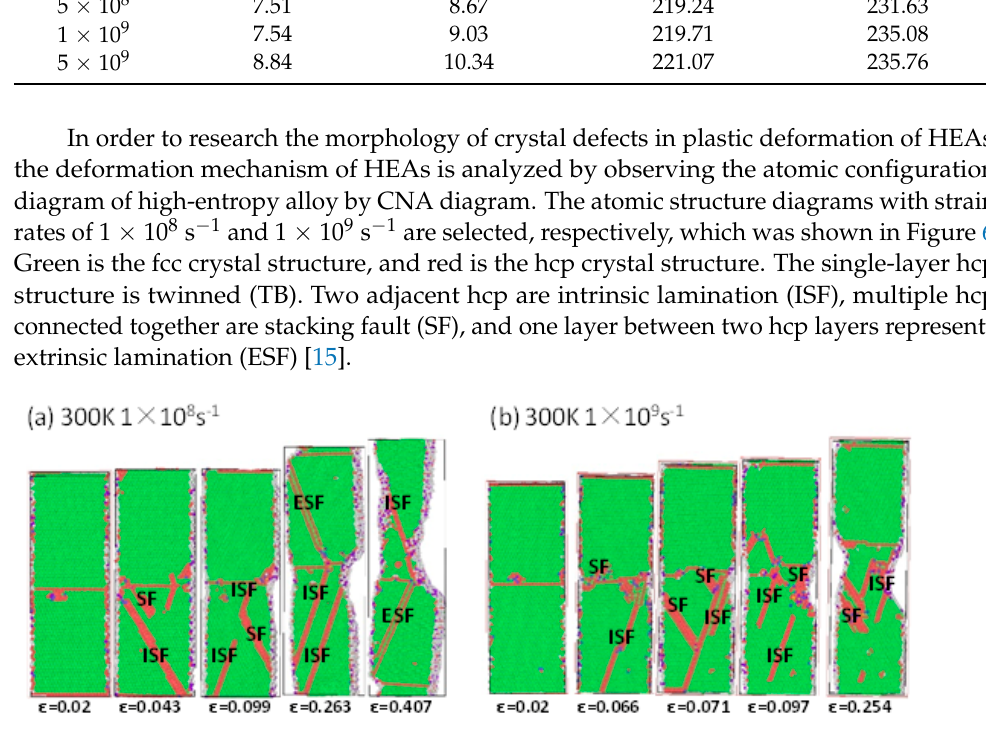
Figure 6. The CNA diagram of GBs HEAs under tensile. ( a ) 300 K, 1 × 10 8 s − 1 ; ( b ) 300 K, 1 × 10 9 s − 1 . For Σ 3 GBs HEAs (Figure 6), the CNA diagram strain rate is 1 × 108 s-1. When the strain is 0.02, there is an SF near the grain boundary. As the strain increases, ISF emerging observed at strain 0.099, and ISF started moving toward the grain boundary. At a strain of 0.263, ISF moves near to grain boundary, and symmetrical ESF appears on the other side of the grain boundary. The ISF and ESF cross in the opposite direction to form obvious defect regions, which become the crack source of fracture. When the strain rate is 1 × 10 9 s − 1 , the CNA diagram under different strains is observed. When the strain is 0.02, there is a stacking fault below the grain boundary. When the strain increases to 0.066, SF moves constantly to the grain boundary and then is blocked by grain boundaries. Therefore, SF is at the grain boundary, and it is difficult to cross grain boundaries. It shows that the grain boundary effectively constrains the movement of the fault or changes the motion direction. Figure 7a is the CNA diagram of the non-GBs HEAs with a strain rate of 1 × 10 8 s − 1 . When the strain is 0.044, SF appears as the strain increases. When the strain is 0.086, an ESF appears throughout the entire model. Figure 7b shows the CNA diagram of the non-GBs HEAs with a strain rate of 1 × 10 9 s − 1 . When the strain ranges from 0.071 to 0.075, the ISF and ESF can move through the whole grain. It can be seen from Figure 7 that different types of SF can move in the whole model under different strain rates in non-GBs HEAs. At the same time, the fracture is more difficult to occur in the non-GBs HEAs than in the Σ 3 GBs HEAs. In non-GBs HEAs, the movement of the ISF and ESF will not be hindered by grain boundary, so it will not cause the accumulation of stacking fault. In addition, dislocation is also a major factor in influential performance. DXA was used to analyze dislocations with different strain rates, as shown in Figures 8 and 9. Green is 1/6<112>